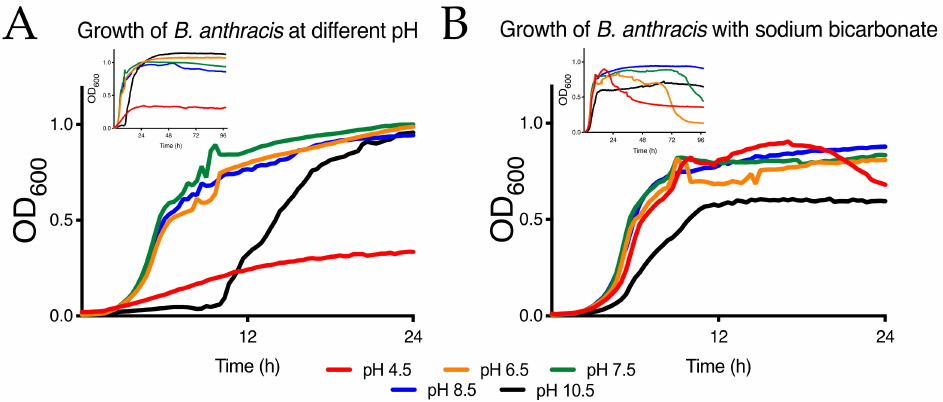
Figure 2. Growth of B. anthracis at di ff erent pH. ( A ) Short-term and long-term (inset) growth of B. anthracis at di ff erent pH. Highly acidic pH is especially detrimental to bacterial survival while alkaline pH delays growth but does not impact long-term growth. ( B ) Short-term and long-term (inset) growth of B. anthracis at di ff erent pH in the presence of bicarbonate. The bu ff ering capacity of bicarbonate is evident by increasing short-term growth rates of B. anthracis . Longer term, bacterial survival is optimal at pH 8.5 and 10.5 while optical density sharply decreases at neutral and acidic pH starting at 24 h after